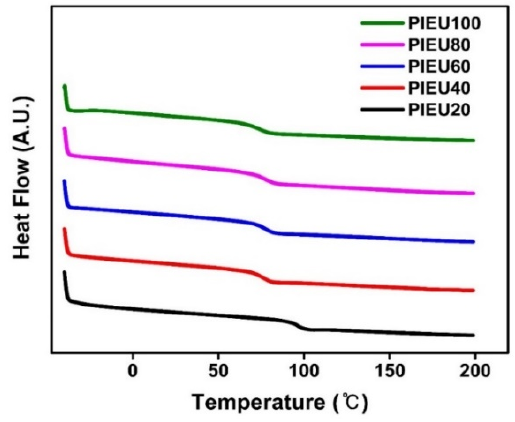
Figure 3. DSC (differential scanning calorimetry) thermogram of isoeugenol-modified polystyrene (PIEU#).